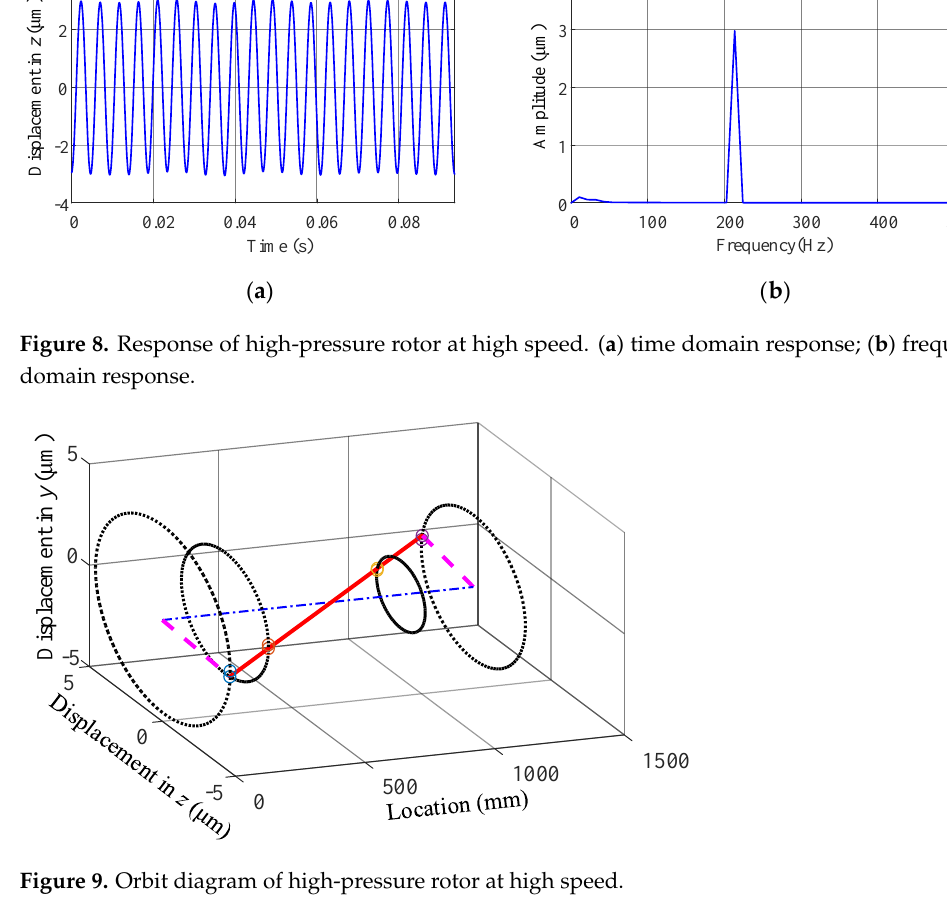
Figure 9. Orbit diagram of high-pressure rotor at high speed.